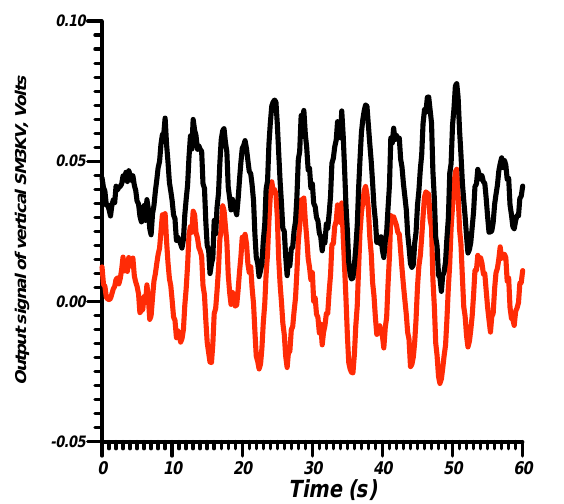
FIG. 4. (Color) Signals from two vertical SM3-KV geophones separated by 32 m (measured at night on September 17 and 18, 1997 on the E4R building floor). Figure 5 presents the distribution of the displace- ment amplitudes of horizontal ground vibrations at E4R.